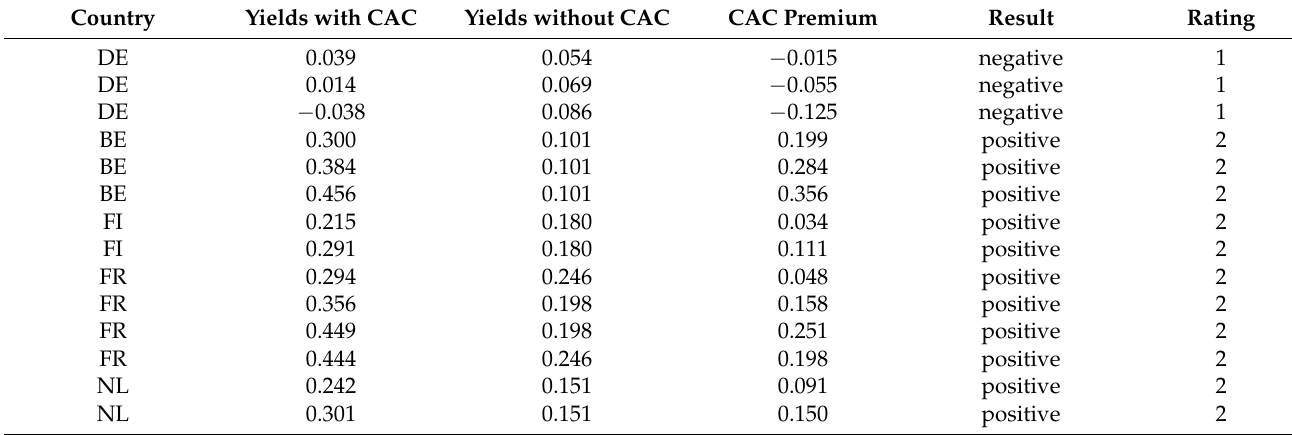
Table A3. CAC premium for 10-year sovereign bonds (Source: